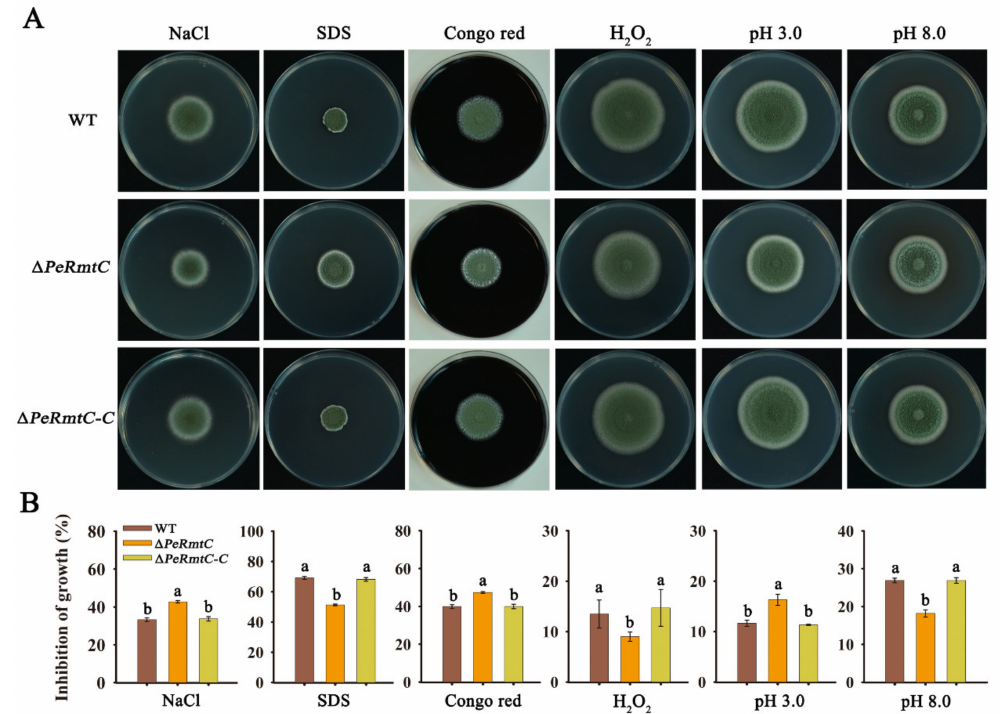
Figure 7. PeRmtC is involved in stress responses of P. expansum . ( A ) Morphologies of the WT strain, ∆ PeRmtC , and ∆ PeRmtC-C after 7 d of stress treatments (1.5 M NaCl for osmotic stress, 0.2 mg mL − 1 SDS for membrane stress, 6.5 mg mL − 1 Congo red for cell wall stress, 2.1 mM H 2 O 2 for oxidative stress, pH 3.0 and 8.0 for ambient pH stress). ( B ) Inhibition rate of growth in different stress treatments. The experiments were performed with three biological replicates. Columns with different letters are significantly different ( p <